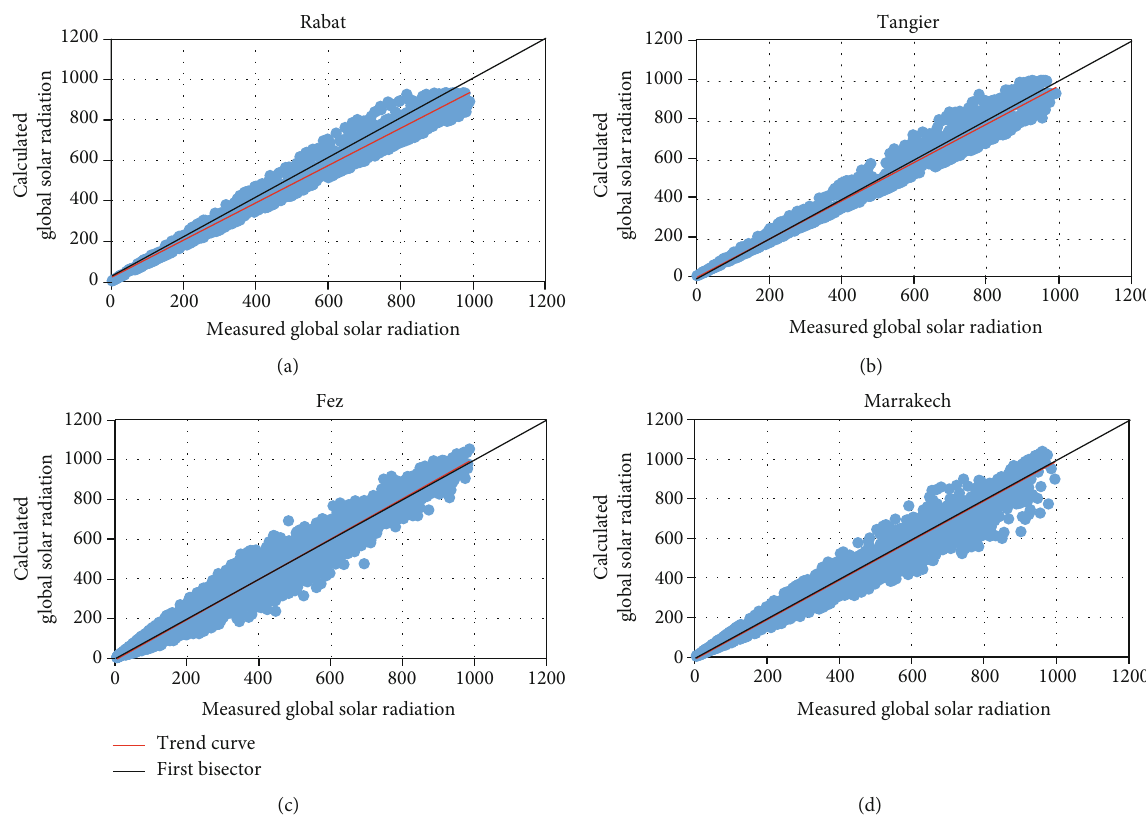
Figure 7: Graphical representation of the estimated values according to the measured values for global radiation of Rabat (a), Tangier (b), Fez (c), and Marrakech (d). Table 11: The performance of used model for predicting I